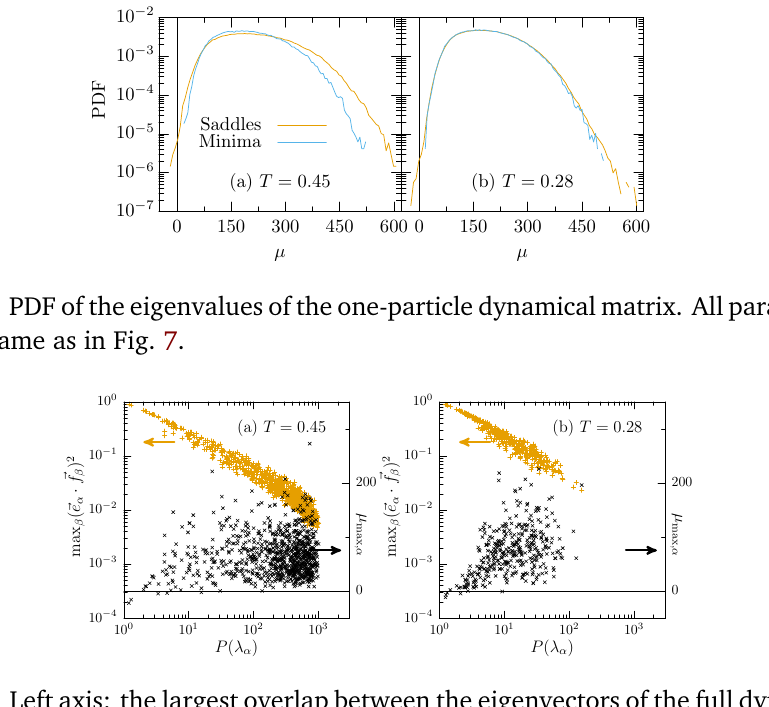
Figure 9: Left axis: the largest overlap between the eigenvectors of the full dynamical (cid:126) f β ) 2 . Right axis: the corre- matrix and the one-particle dynamical matrix max β ( (cid:126) e α , sponding eigenvalue µ . The abscissa is the participation ratio. We show the data max, α for saddles at (a) T = 0.45 and (b) T =